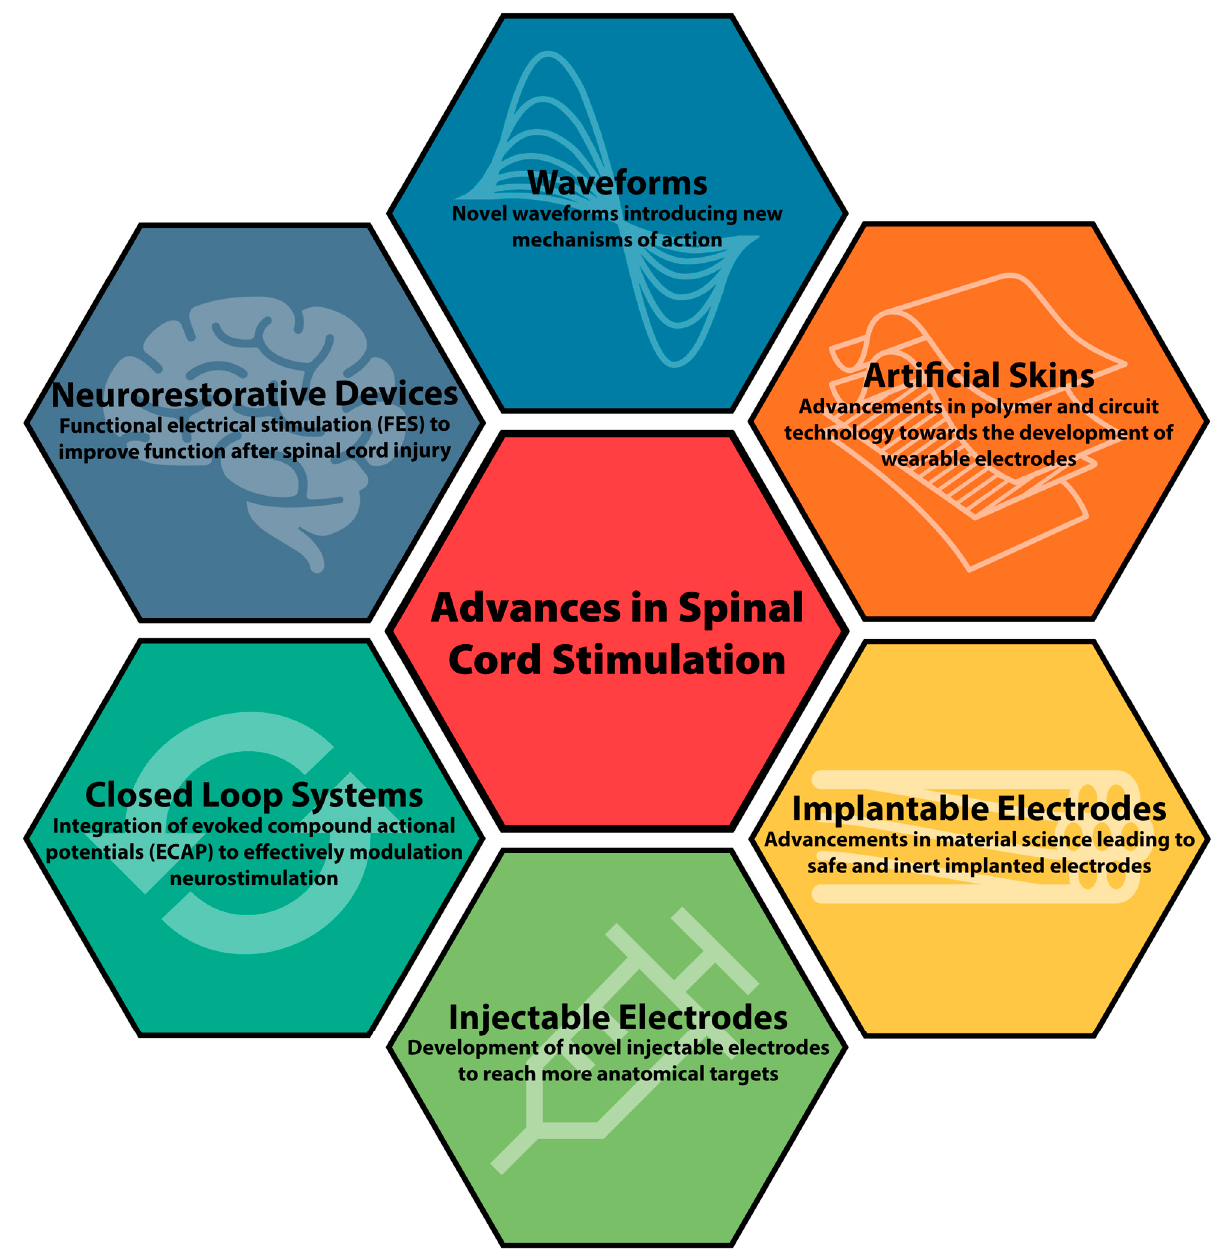
Figure 1. Schematic summary for advances in spinal cord stimulation.